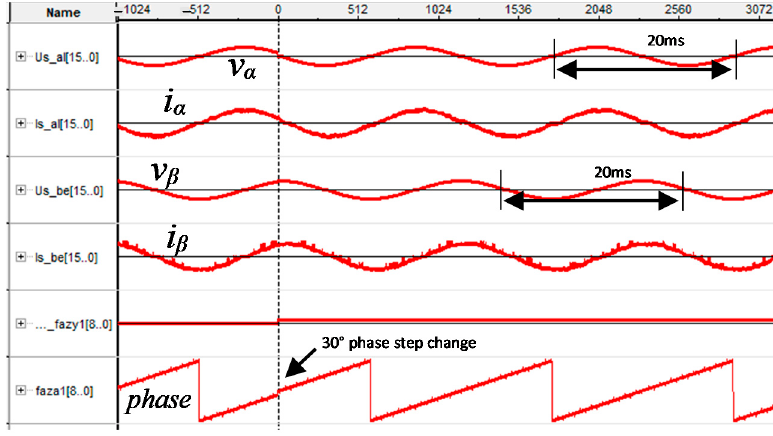
Figure 17. Step phase change of grid voltages (+30 ◦ ) at constant active component 0.7 P N .